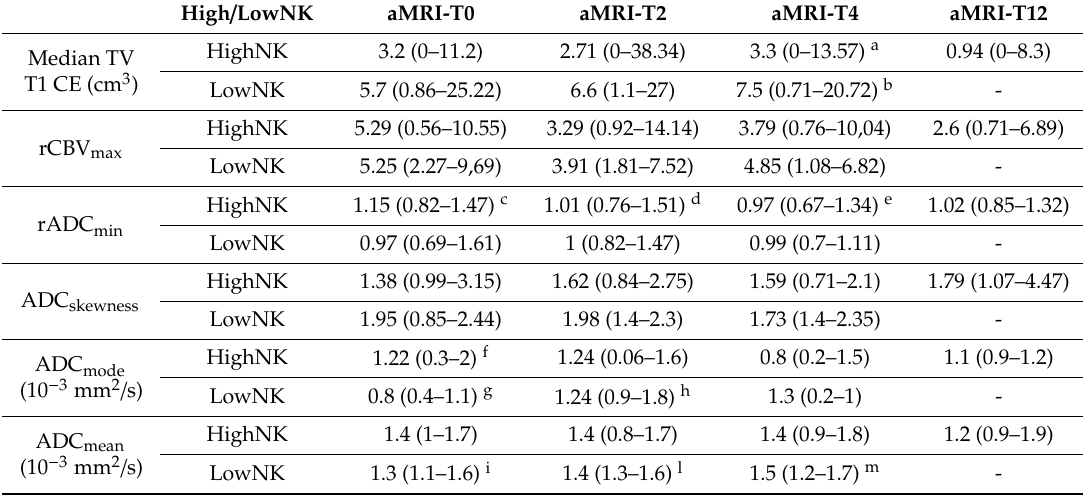
Table 3. Median values with range observed before (MRI-T0) and during immunotherapy in High and Low NK